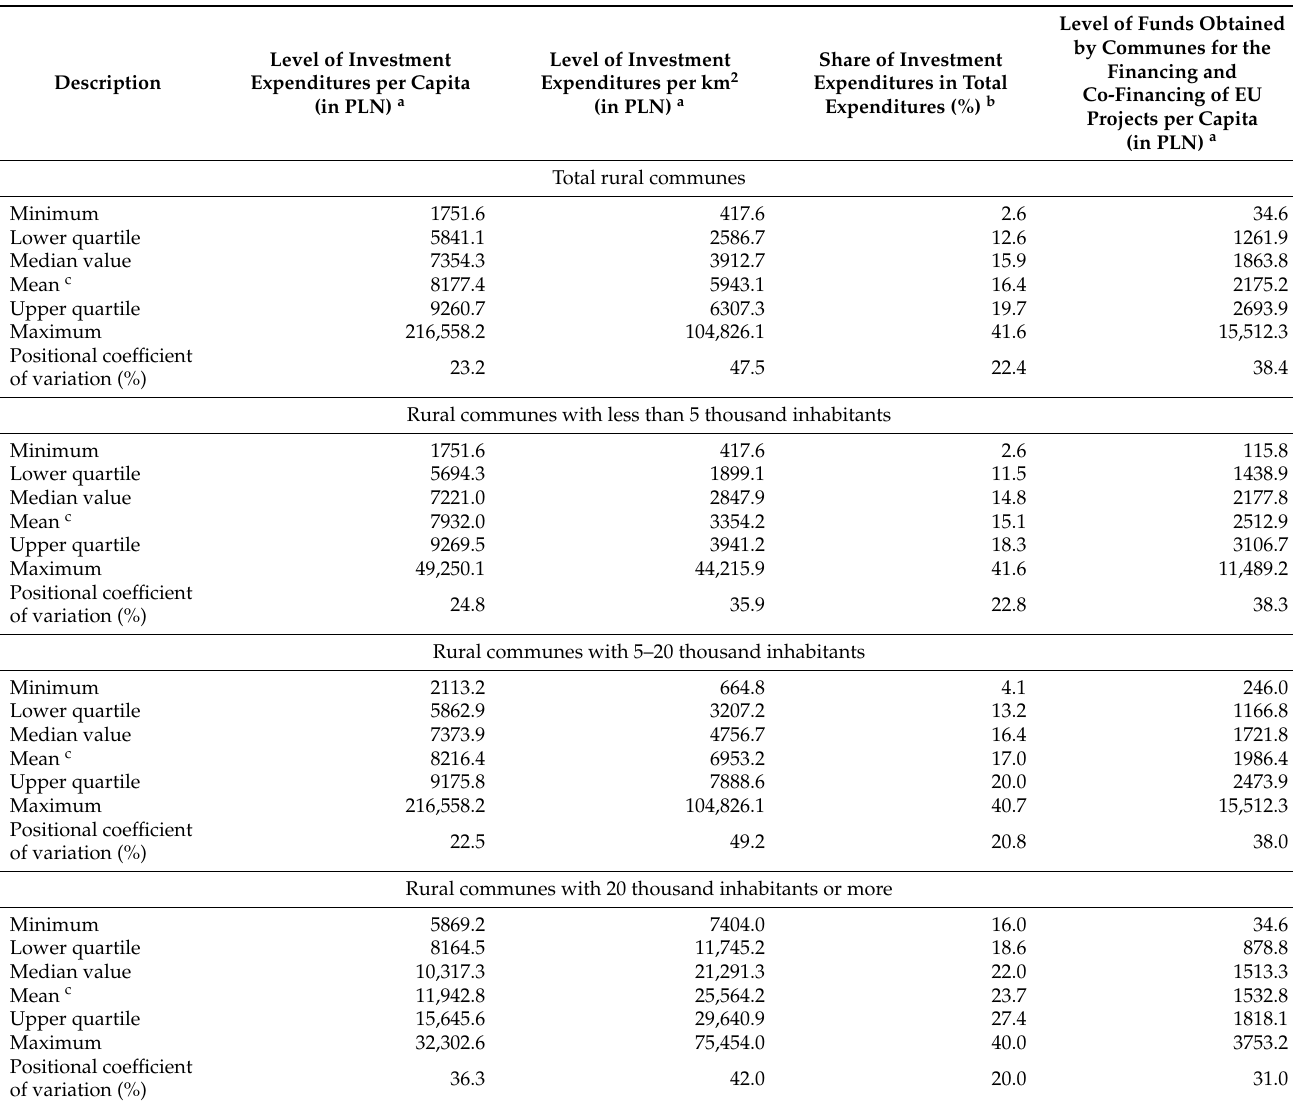
Table 3. Indicators illustrating the level of investment activity of rural communes by population in Poland in the